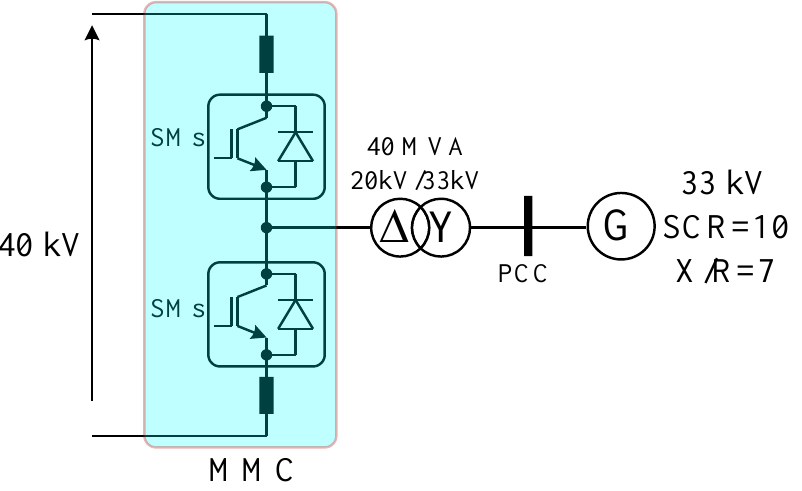
Figure 7. Simplified single line diagram of the 40 kV, 40 MVA, and 20-cell MMC connected to ac grid.